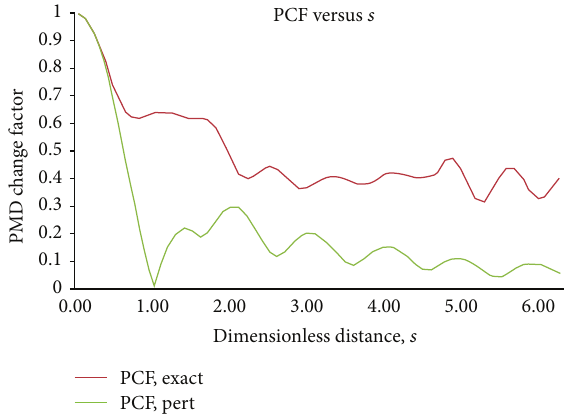
Figure 4: The PCF curve for a nonperturbative limit with Λ = 5 and 𝐿 𝐵 = 1 .